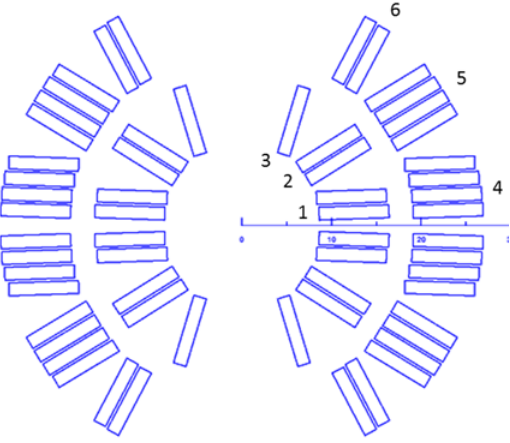
Figure 1. Optimized coil cross ‐ section with block numbering in the 1st quadrant. Table 1. Geometrical parameters of coil blocks.